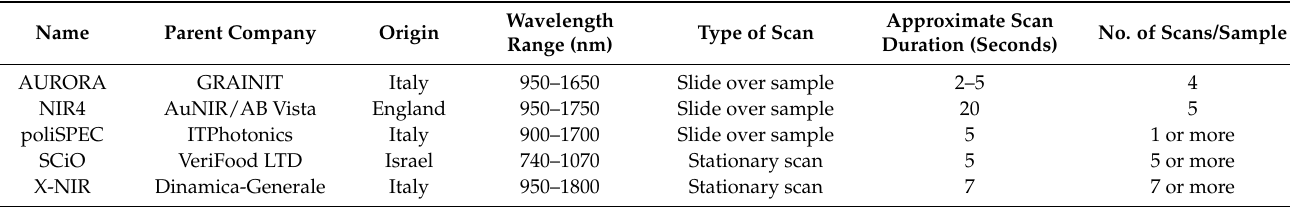
Table 1. List of the main portable spectrophotometers, and related characteristics, currently available adapted from [38], with permission from PRO-DAIRY,